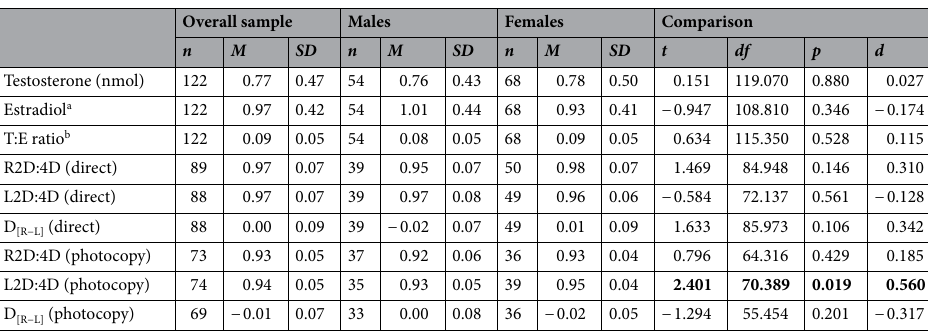
Table 1. Descriptive statistics for digit ratio (2D:4D) and hormone variables. Sample sizes differ for 2D:4D variables because measurements were only taken directly or indirectly from some participants; additionally, in some cases it was only possible to collect data for the right or left hand, e.g., because the second and/or fourth fingertips were missing from the photocopied images. Equal variances were not assumed for each of the independent samples t-tests reported here. Effect displayed in bold is statistically significant ( p < 0.05, two-tailed). a Estradiol was measured in nmol but the values reported here are divided by 10,000 for ease of interpretation. b T:E was calculated as T (nmol)/E (nmol) but the values reported here are multiplied by 1000 for ease of